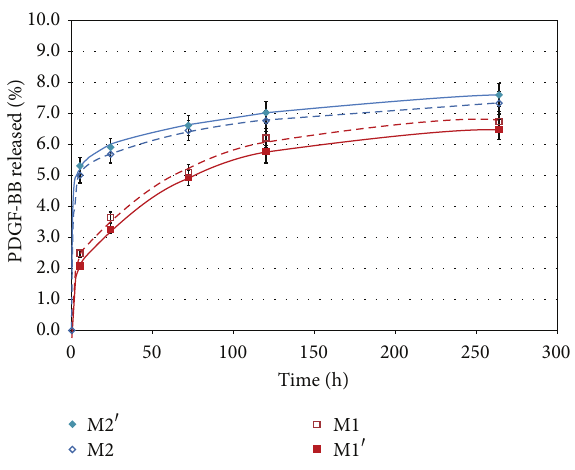
Figure 8: Release profile of PDGF-BB from homogeneous mem- branes, with amoxicillin M1 󸀠 MCCh, M2 󸀠 Fb and without amoxi- cillin M1 MCCh, M2 Fb.